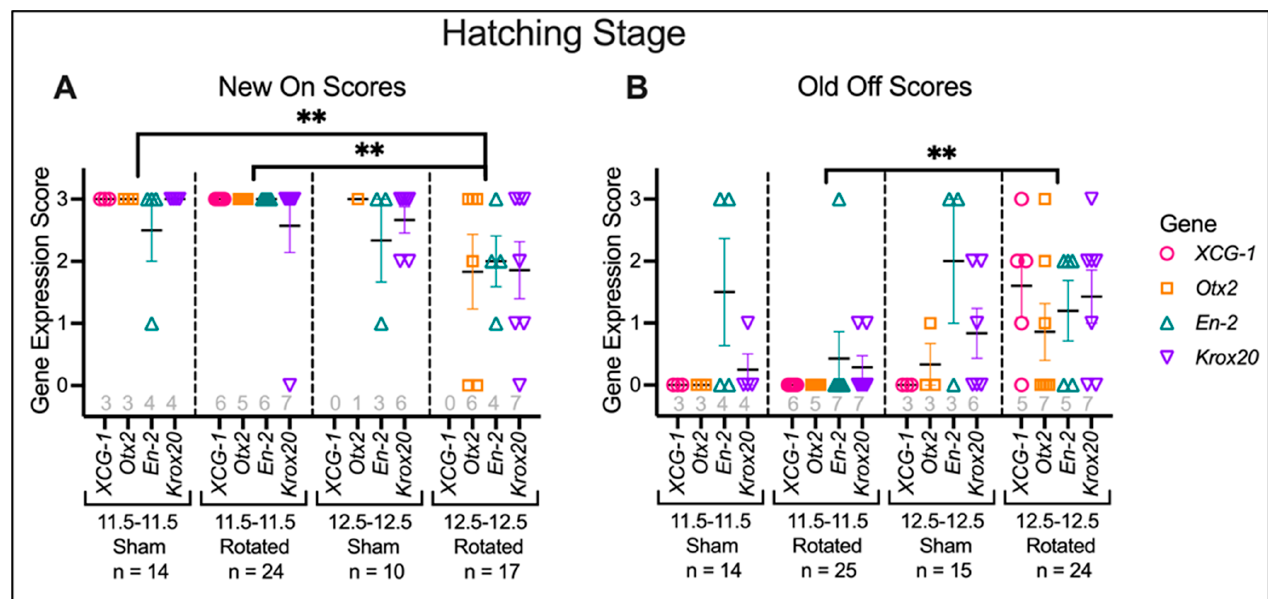
Figure 10. Histology scores for transplants at hatching stage. Histological sections were scored for expression levels of regional marker genes, both correct “New On” expression ( A ) and ectopic “Old Off” expression ( B ). Horizontal black lines represent the mean, and error bars represent the SEM. ** p < 0.01. N for each gene and condition is indicated along the x-axis in gray. Late gastrula rotated embryos have significantly less appropriate marker gene expression than mid-gastrula sham ( p = 0.0064) and Rotated embryos ( p = 0.0012). Late gastrula rotated embryos also have significantly more ectopic marker gene expression ( p = 0.0022) than mid-gastrula rotated embryos.